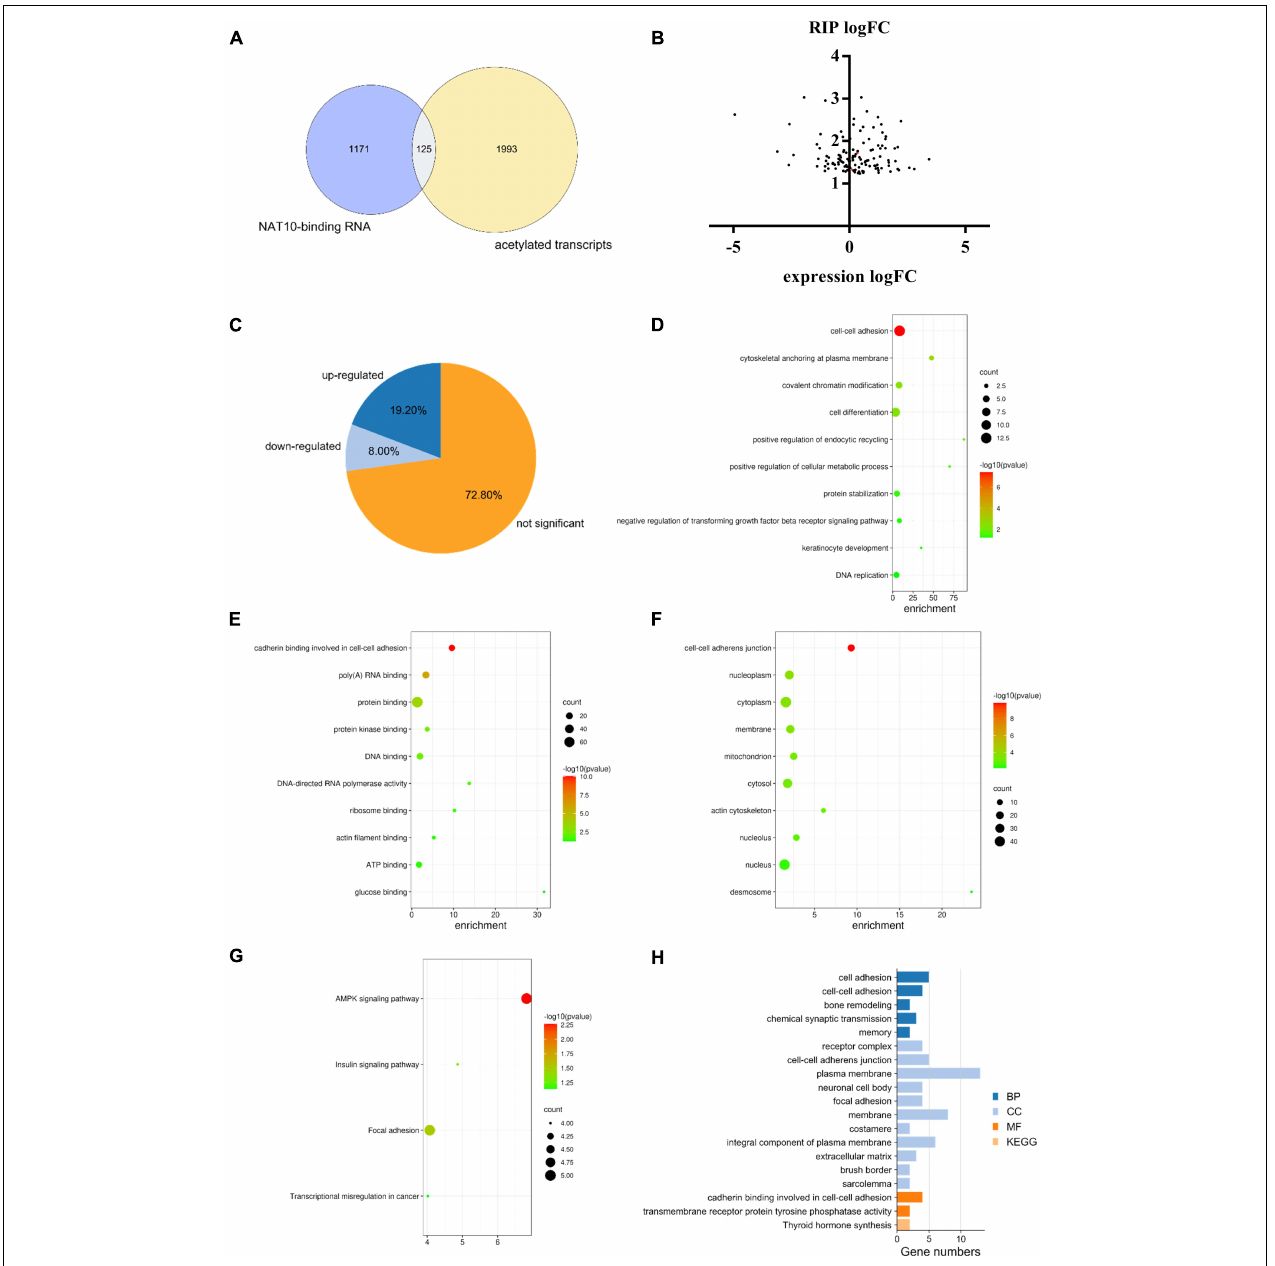
FIGURE 4 | Combined analysis of RIP-seq, transcriptome and acetylated transcripts. (A) Overlap of ac4C transcripts and NAT10-binding RNA identified by RIP-seq. ac4C transcripts were obtained from GEO database (GSE102113), and RIP-seq was performed in this study using HEK293T cells. (B) Expression of NAT10-binding genes in NAT10-overexpressed HEK293T cells. (C) Proportions of up-regulated, down-regulated and not significant genes in the 125 NAT10-binding genes with potential ac4C sites. (D–F) GO enrichment on the subset of down-regulated and not significant genes from (C) , including (D) BP, (E) CC, and (F) MF. (G) KEGG pathway analysis on the down-regulated and not significant genes from (C) . (H) GO enrichment and KEGG pathway analysis on the subset of up-regulated genes from (C) . RIP-seq, RNA immunoprecipitation and high-through sequencing. GO, Gene Ontology. BP, Biological Processes. MF, Molecular Functions. CC, Cellular Components. KEGG, Kyoto Encyclopedia of Genes and